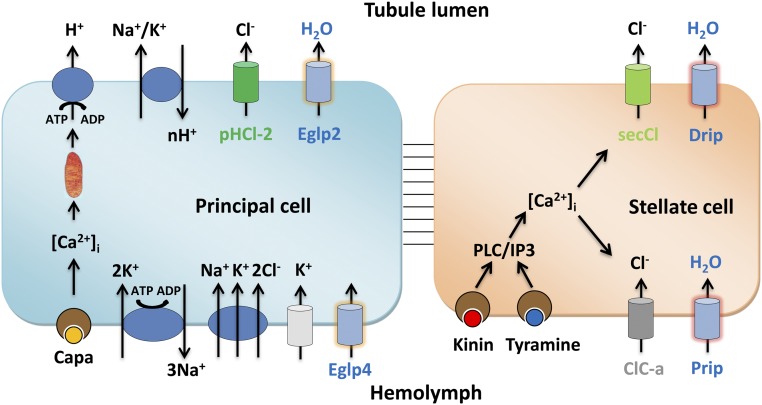
Model for tubule function. The mitochondria-rich principal cell is specialized for metabolically intensive cation and solute transport. The apical V-ATPase sets up a proton electrochemical gradient which drives net K+ secretion via NHA or NHE exchangers. Basolateral K+ entry is afforded by inward rectifier K+ channels, Na+,K+ ATPase and an Na+,K+,2Cl− cotransport. The resulting lumen-positive potential drives a chloride shunt conductance, mainly via basolateral ClC-a and apical secCl channels in the stellate cell. The net transport of KCl drives osmotically obliged water, which is primarily via basolateral Prip and apical Drip in the stellate cells. In this way, the metabolically active principal cell is sheltered from the required high flux rates of water.